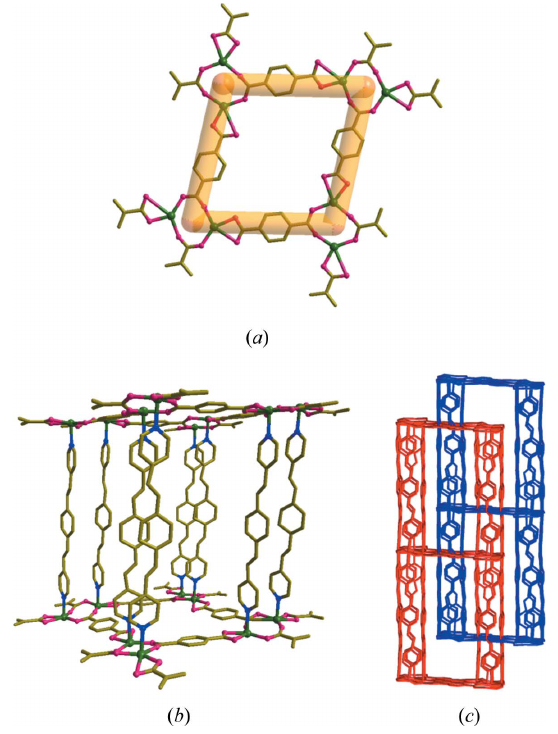
Figure 2 ( a ) The (4,4) net formed by Zn 2 (bdc) 2 in ( 1 ). ( b ) Single pcu unit showing the orientations of the bpeb pillars. ( c ) Twofold parallel interpenetration of the pcu units. For clarity, the disorder and hydrogen atoms are not